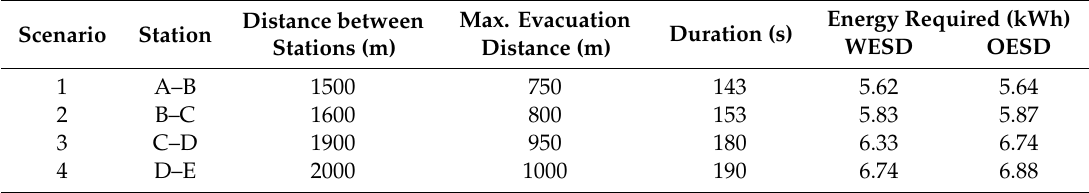
Table 3. WESD and OESD results for emergency feeding.